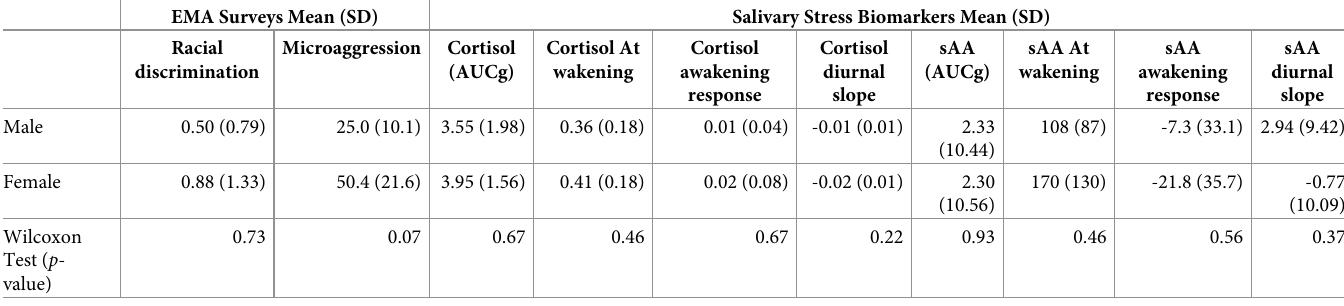
Table 3. Baseline characteristics, average scores of the EMA survey, and salivary stress biomarkers by sex (n =